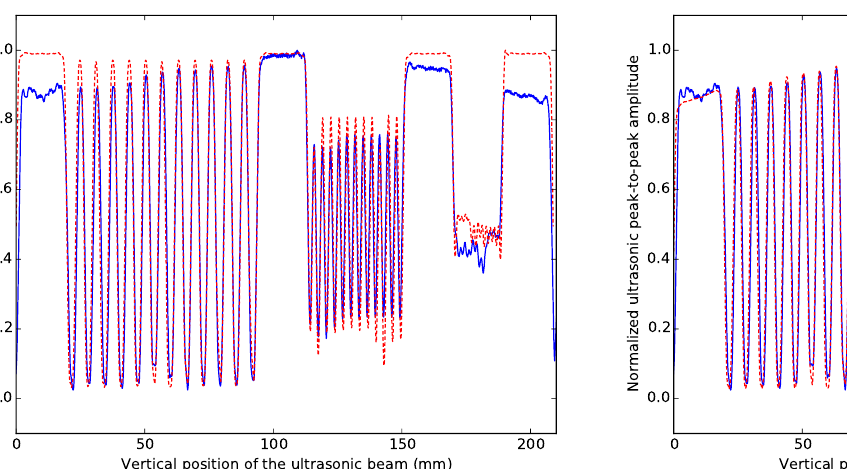
Fig. 12. One-dimensional C-scan of the amplitude of the water experiment. Red dotted: CIVA simulation with 0.7 degree rotation of the mock-up around the beam axis at middle position of the sweep, blue: experiment.